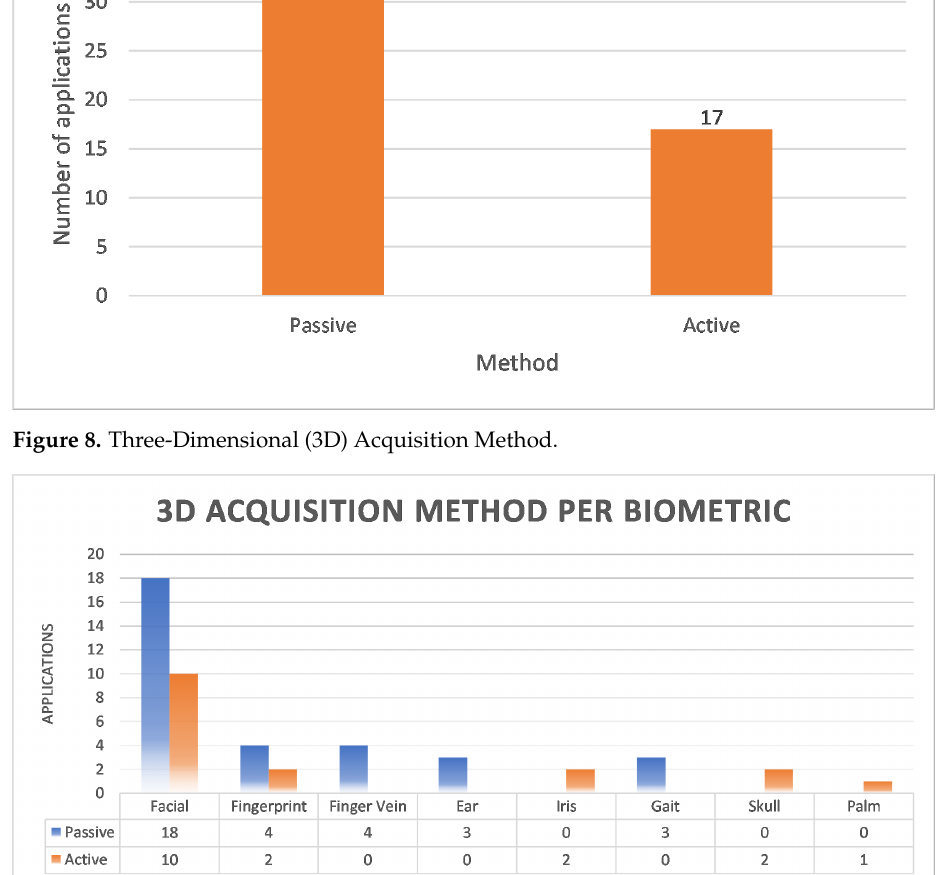
Figure 9. Three-Dimensional (3D) Acquisition Method per Biometric.